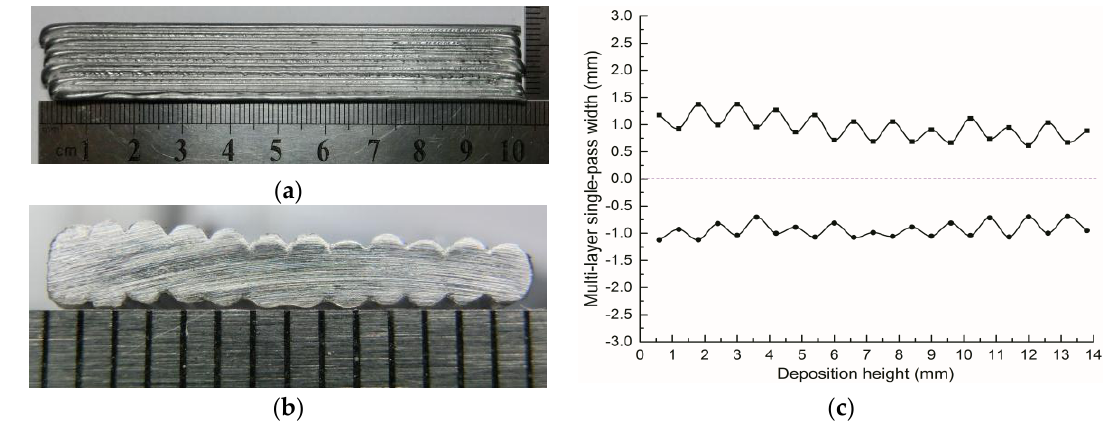
Figure 6a, the thin-walled specimen was formed based on the following process parameters: a deposition velocity of 18 mm/s, a flow rate of 50 mm 3 /s, and a layer thickness of 1.2 mm. The cross section of the specimen is shown in Figure 6b, and the corresponding measured data was shown in Figure 6c. The waviness indexes were analyzed, and the results are as follows: W a = 0.9448, W q = 0.963, and W z = 0.303.